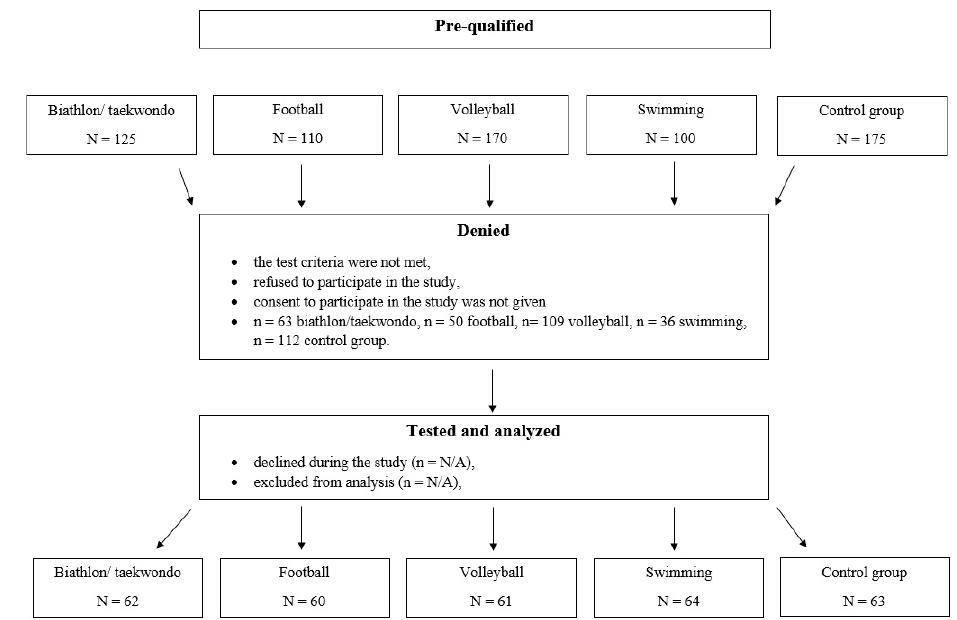
Figure 2. A diagram showing the participation of the respondents in the subsequent stages of the